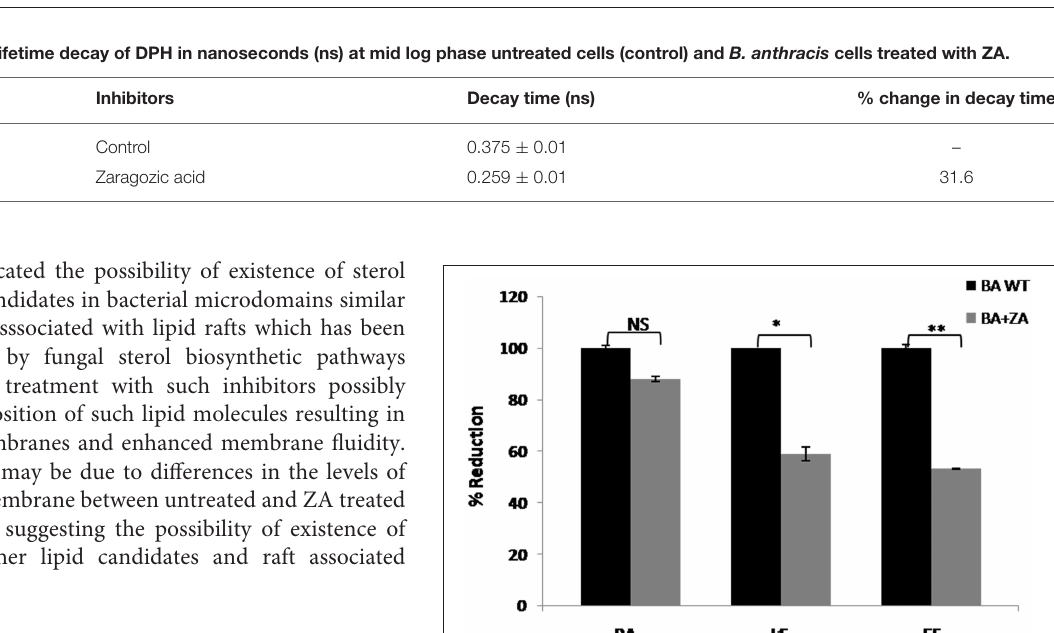
FIGURE 10 | Effect of ZA on membrane fluidity of B. anthracis. (A) Mean fluorescence polarization “ p ” values (inversely propotional to membrane fluidity) of B. anthracis grown in absence (control) and presence of ZA. (B) Decay curve for DPH labeled B. anthracis grown with or without ZA. (C) Time dependent Fluorescence decay (with fits) in linear scale with respect to time in nanoseconds of DPH in the ZA treated and untreated cells.